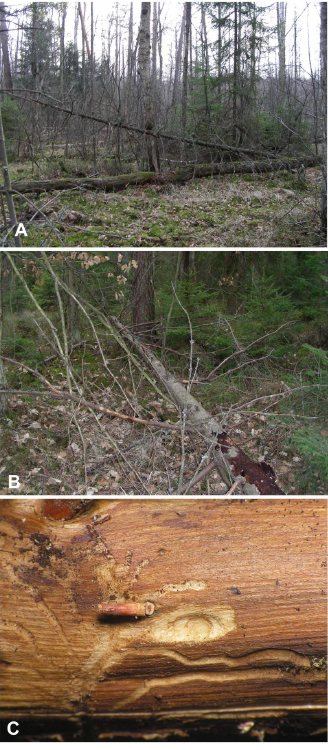
Figure 1. Biotope of Euryommatus mariae . ( A ) Forest in Cisów (Świętokrzyskie Mts., Poland); ( B ) dead spruce hosting the larvae; ( C ) larval gallery.